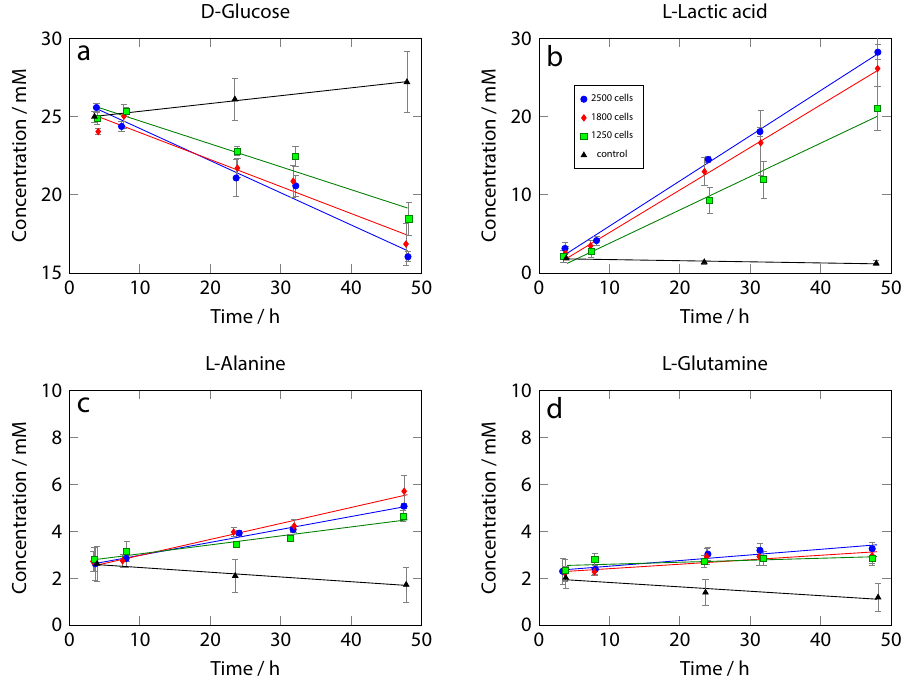
Figure 6. Metabolite concentrations in monolayer culture over time. d-Glucose (a) , l-Lactic acid (b) , l-Alanine (c) , and l-Glutamine (d) changes in 2.5 µ L volume. Error bars represent twice the standard deviation of three separate experiments.